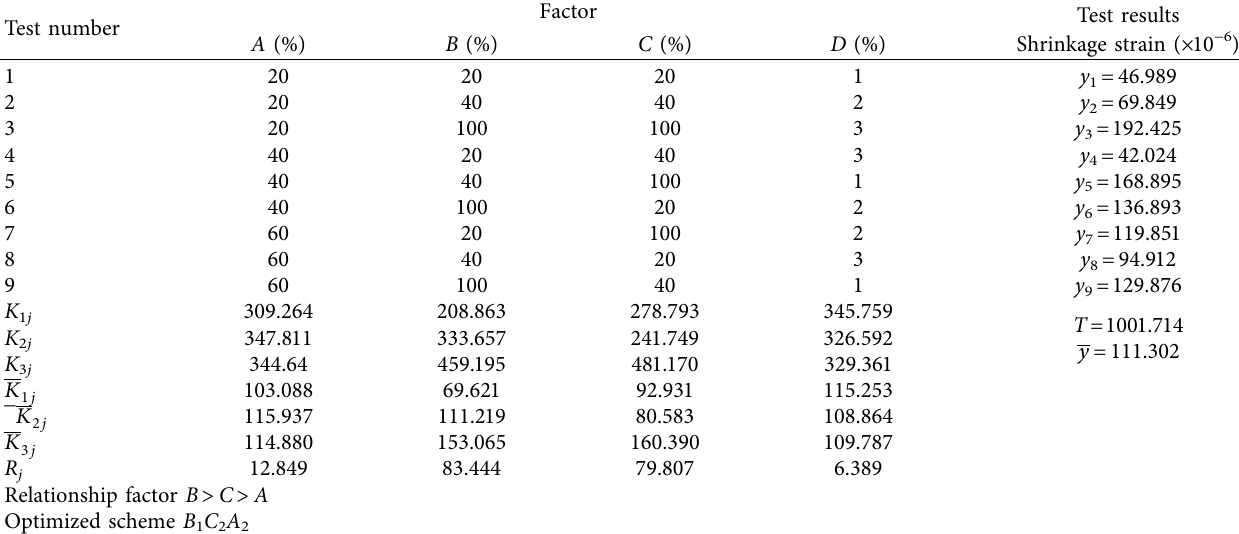
Table 5: Test results and calculation